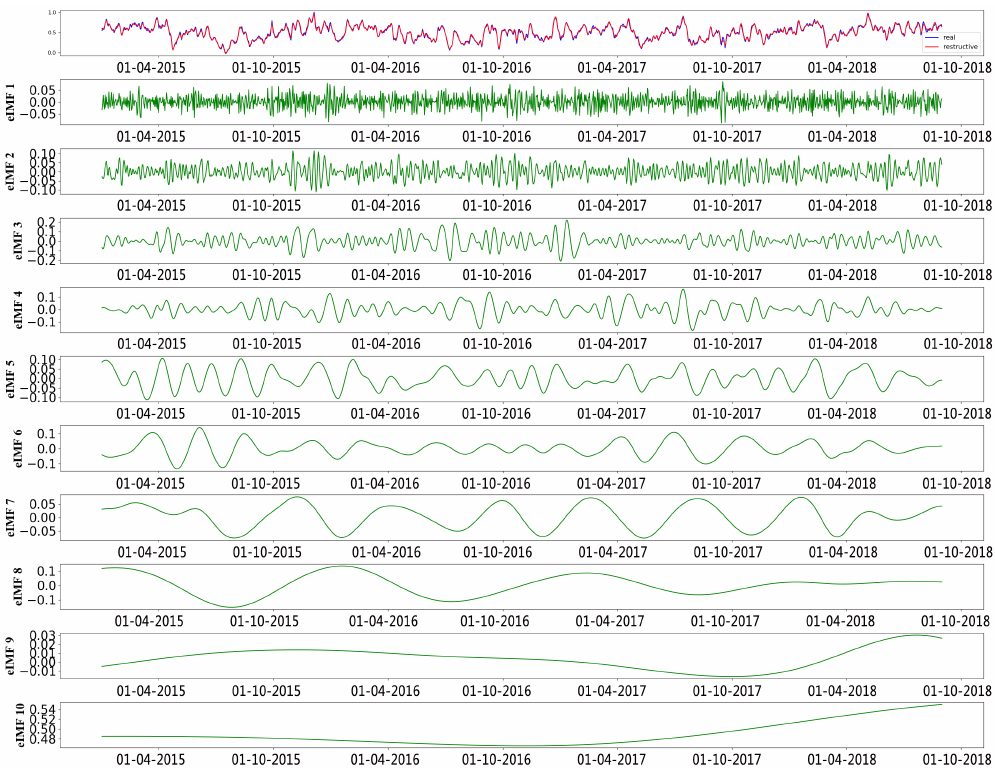
Figure 6. The decomposing results of the NAO index with EEMD.